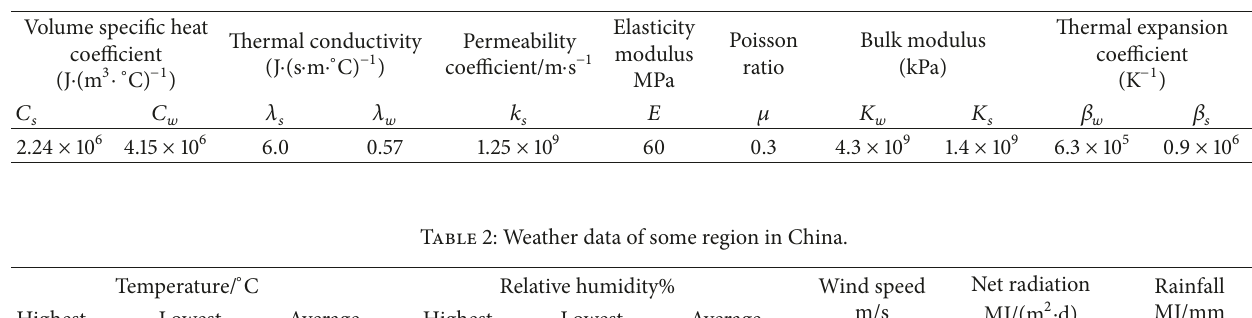
Table 1: Calculation parameter.